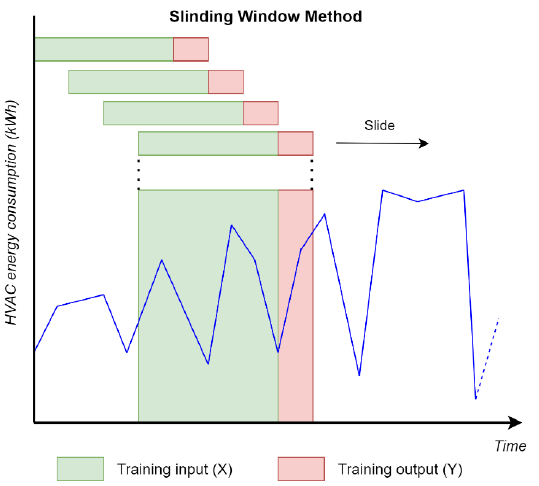
Figure 4. Example of use of sliding window method to transform time series data to supervised learning.